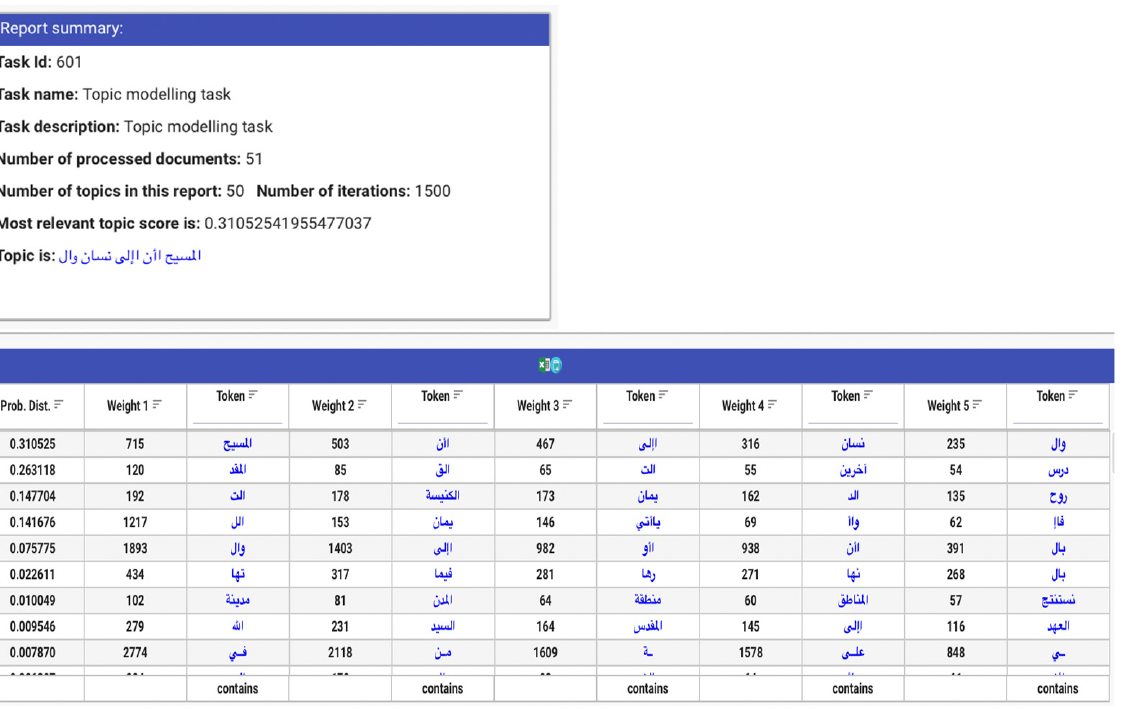
Figure 5. Topic modelling.